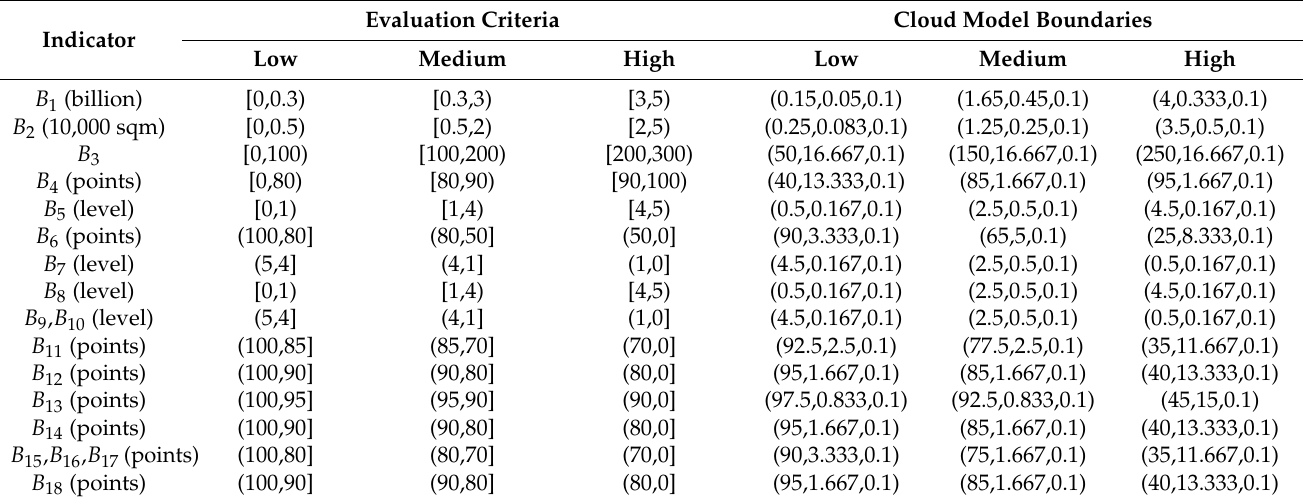
Table 3. Criteria for evaluating the safety performances of construction projects under influences of psychological states and cloud model boundaries.